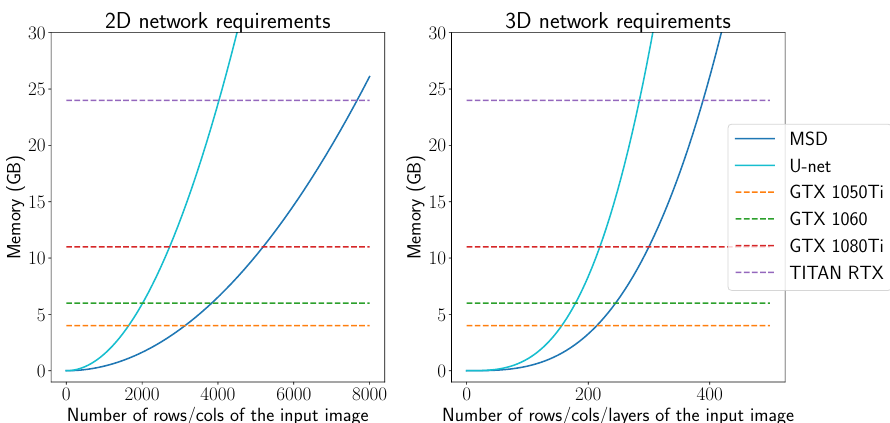
Figure 4. The required memory to store all intermediate images for applying a 2D and 3D U-net and MSD-net as a function of the input image